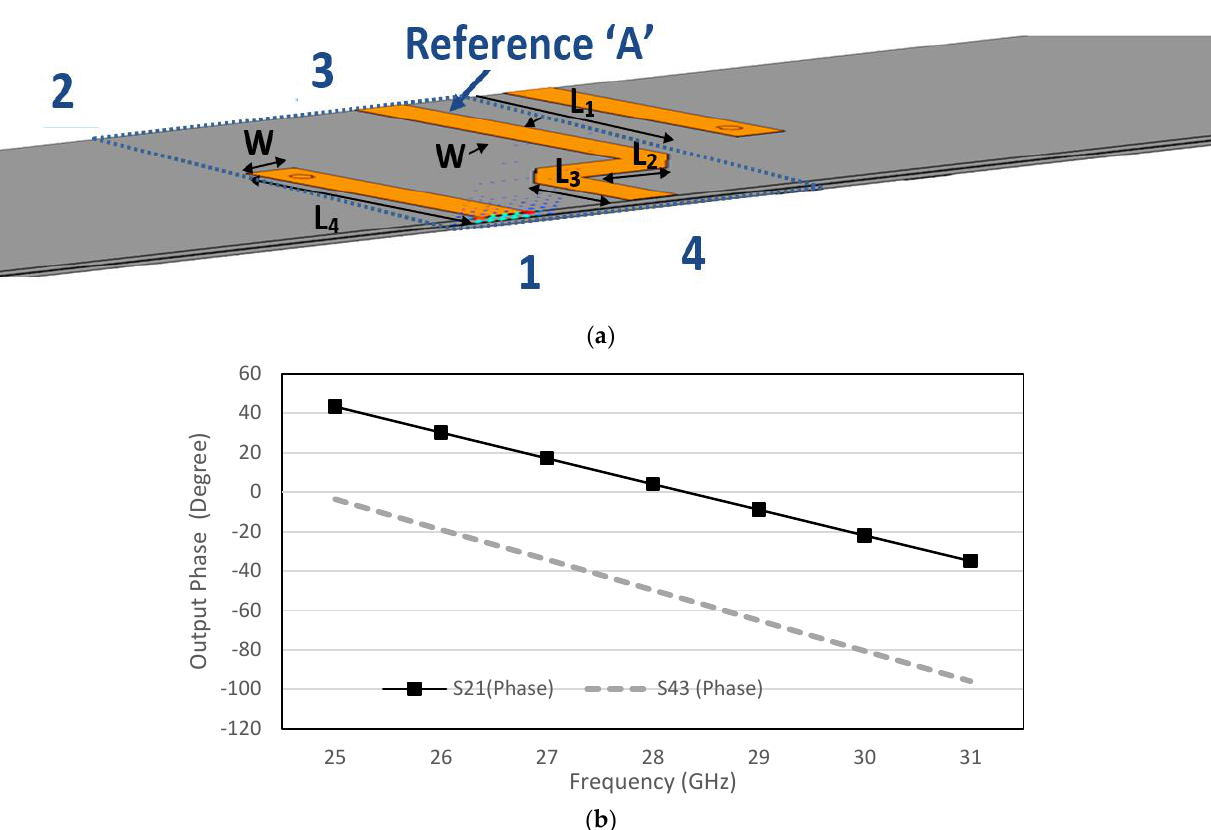
Figure 15. Via-hole with reference ‘ A ’: ( a ) configuration and ( b ) output phase, φ 1 and φ 2 .